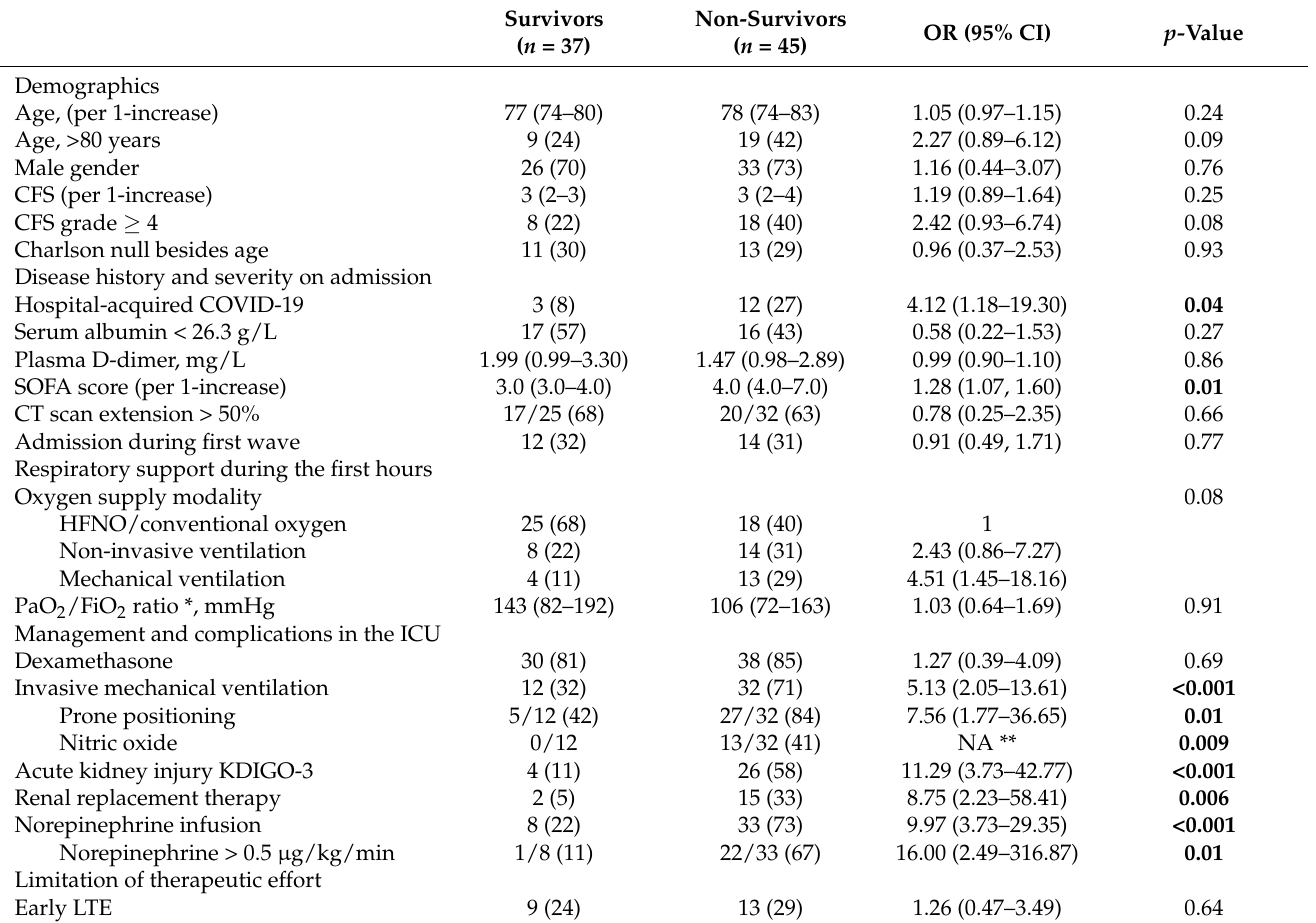
Table 3. Predictive factors of in-hospital mortality in critically ill COVID-19 elderly patients managed in the intensive care unit based on univariate